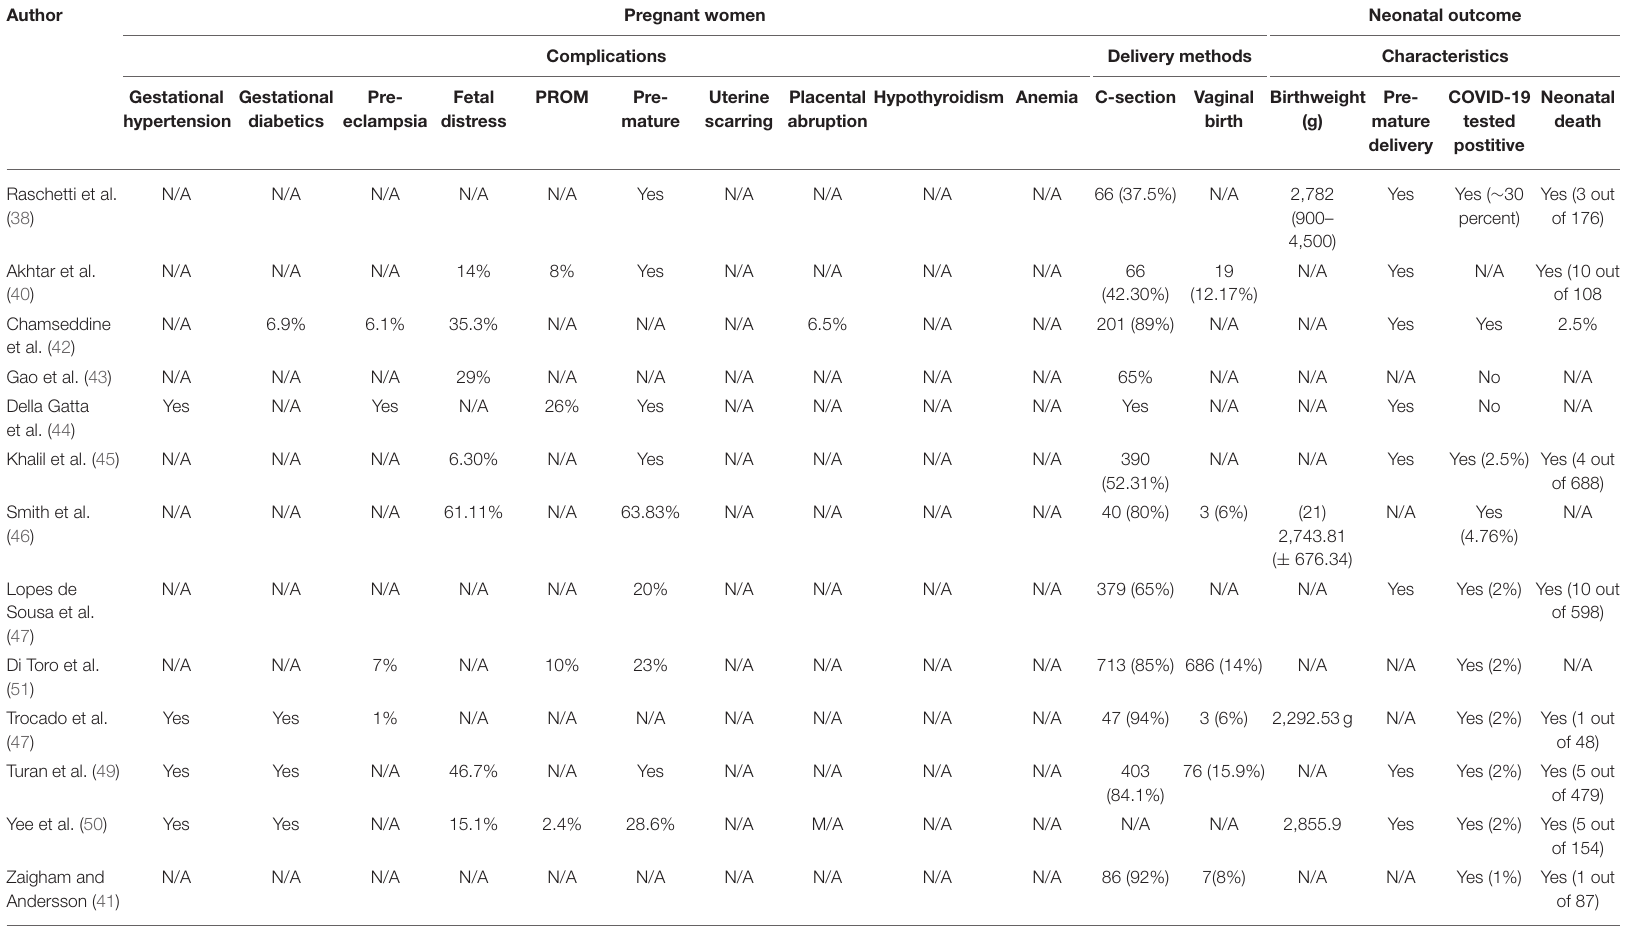
TABLE 5 | Pregnant women and neonatal outcomes compression among recent